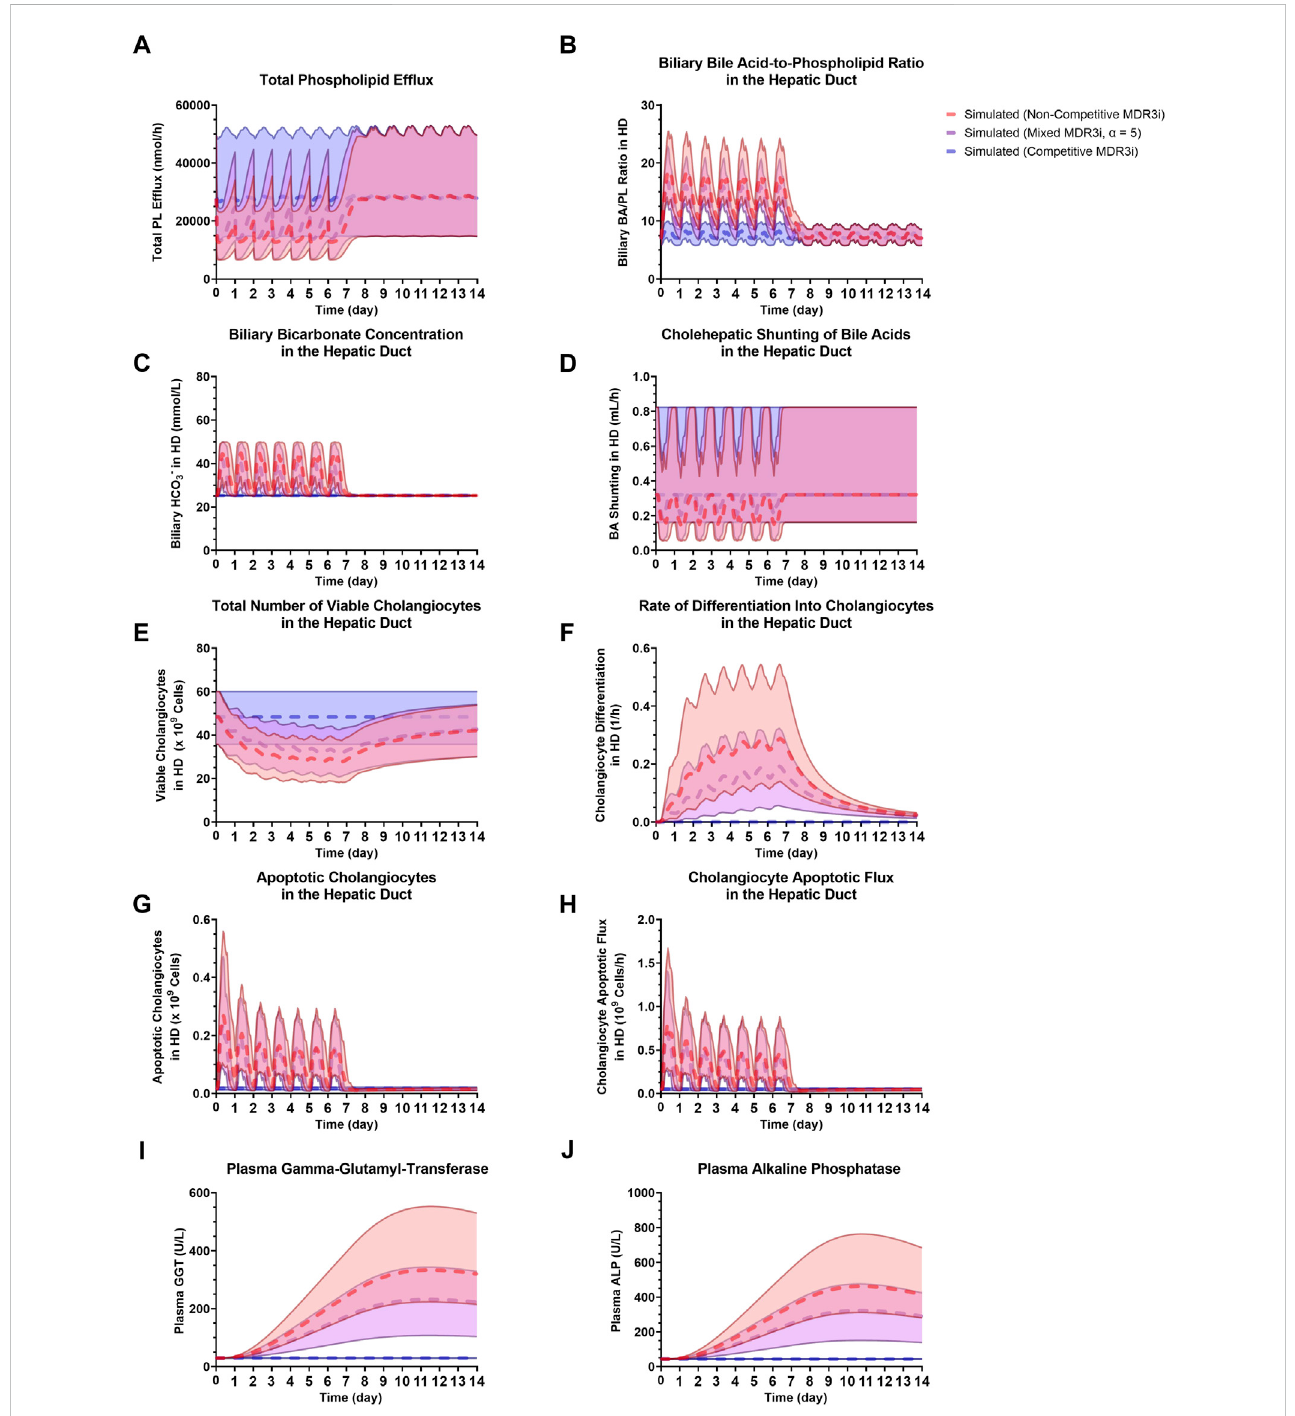
FIGURE 7 Comparison of non-competitive MDR3 inhibition, mixed MDR3 inhibition ( α = 5) and competitive MDR3 inhibition for (A) total PL ef fl ux, (B) biliary BA/PL ratio in the HD, (C) biliary HCO 3 − in the HD, (D) BA shunting in the HD, (E) viable cholangiocytes in the HD, (F) cholangiocyte differentiation in the HD, (G) apoptotic cholangiocytes intheHD, (H) cholangiocyteapoptotic fl uxintheHD, (I) plasmaGGT, (J) plasma ALP.Dashedpro fi lesindicatetheSimPopsaverage for the three modes of inhibition, while the 2.5 th – 97.5 th percentiles of the SimPops are depicted by the transparent shading. ALP, alkaline phosphatase; BA, bile acid; HCO 3 − , bicarbonate; HD, hepatic duct; MDR3, multidrug resistance protein 3; MDR3i, MDR3 inhibition; PL,